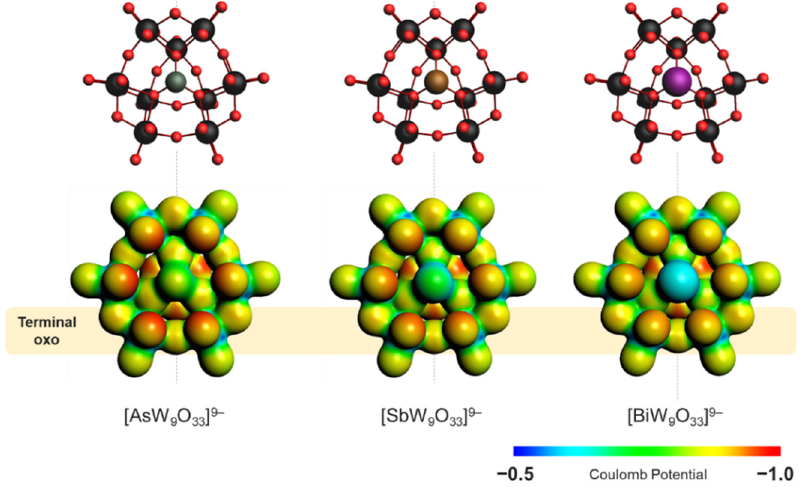
Figure 2. Ball-and-stick representation ( top ) and molecular electrostatic potential plotted over the density isosurface ( bottom ) of the three different trilacunary polyanions for qualitative comparison. Color code: As = green, Sb = brown, Bi = violet, W = black, and O = red. The most basic sites ( bottom row ) are shown with red coloring.